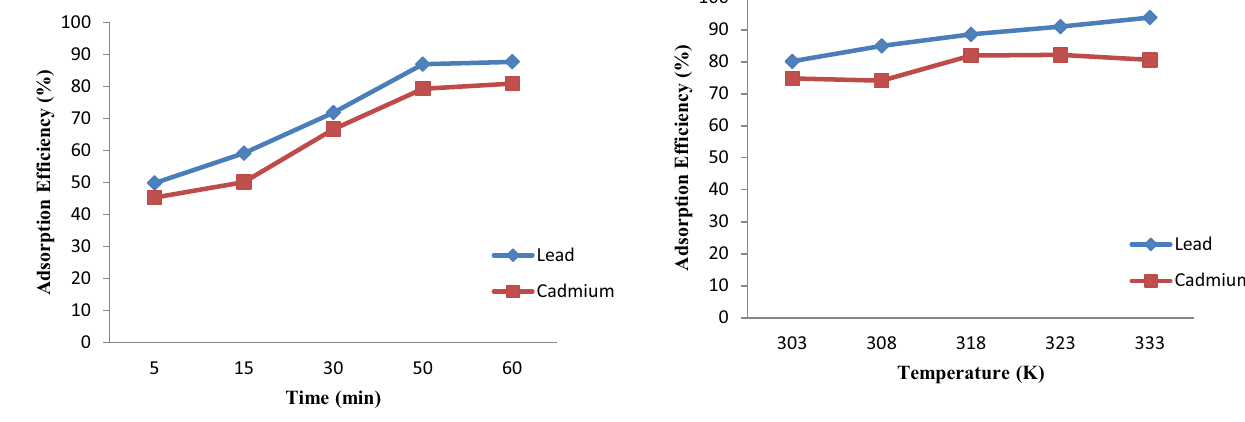
Fig. 3 Effect of Time on Pb 2+ and Cd 2+ Adsorption by Opi soil